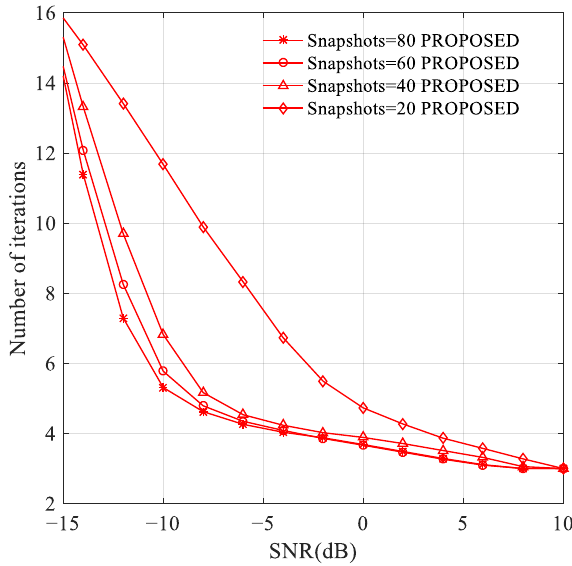
Figure 3. The number of iterations versus the input SNR.